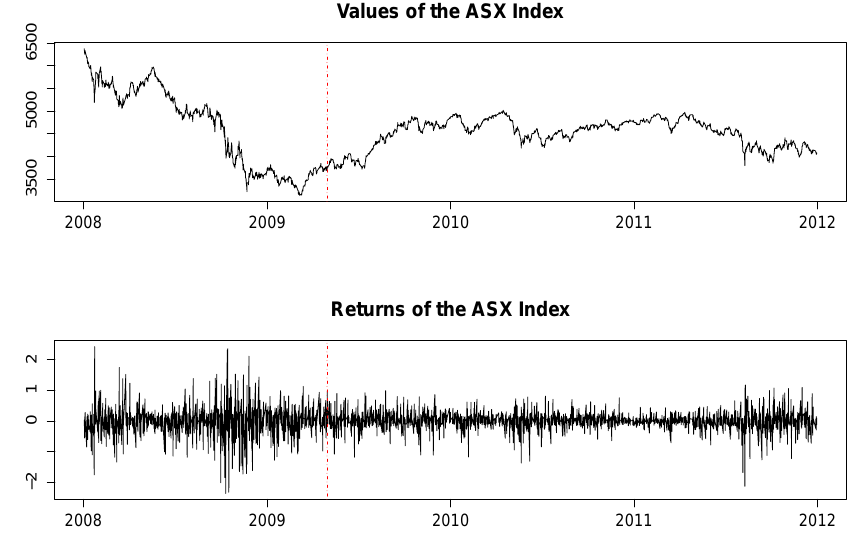
Figure 1. Evolution of the ASX index during the Global Financial Crisis